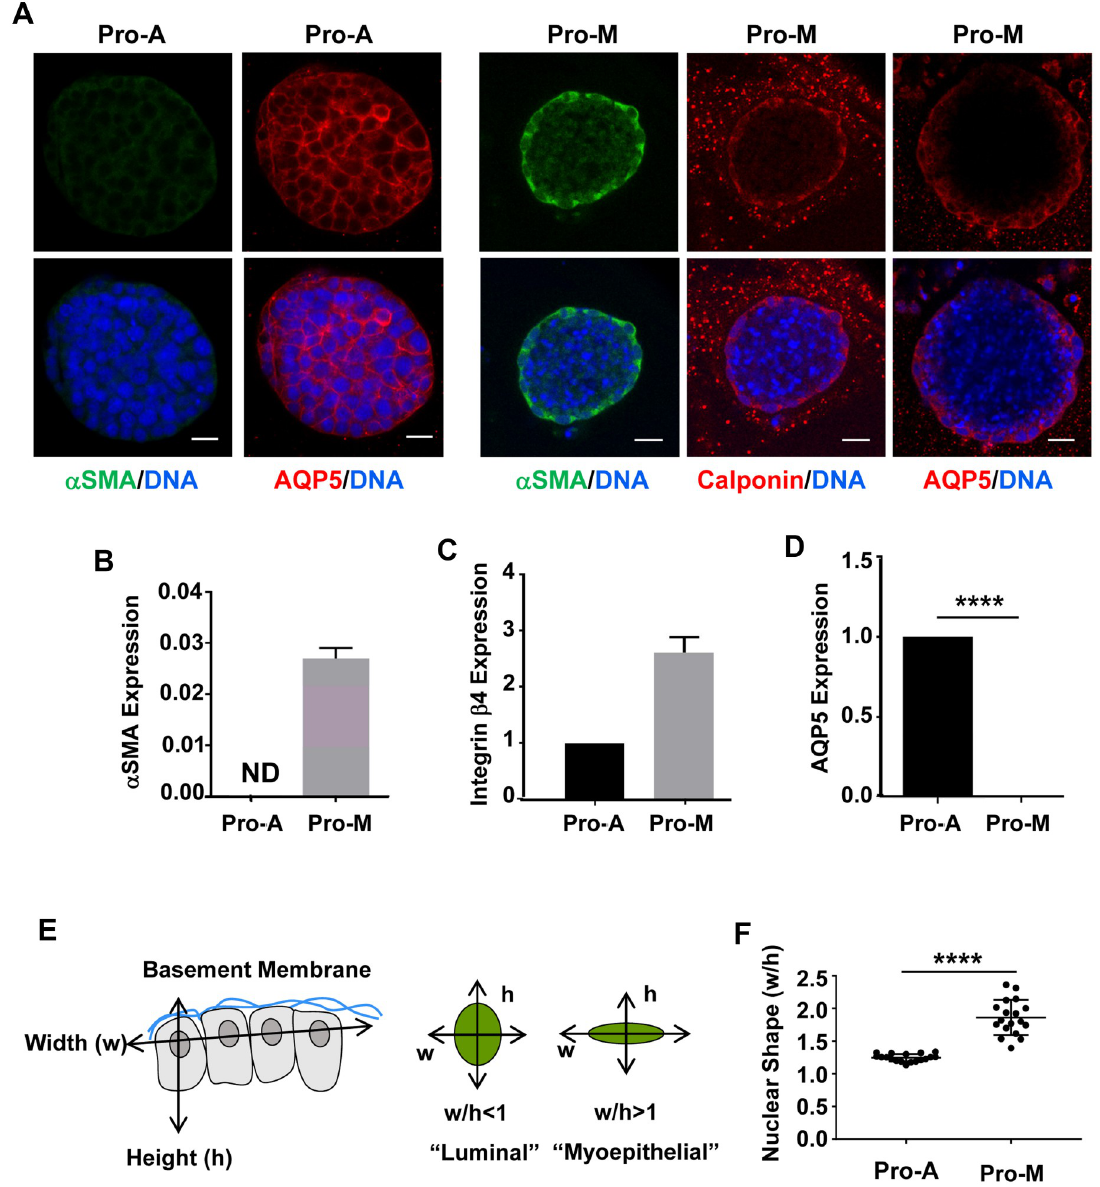
Fig 1. mSG-PAC1 cells can be induced to express myoepithelial markers and characteristics. (A) Representative confocal images of mSG-PAC1 spheroids cultured for six days in Matrigel in either a medium (Pro-A) that promoted pro-acinar phenotype or a medium (Pro-M) that promoted a myoepithelial phenotype and then immunostained for α SMA, calponin, AQP5 and DNA. Images are maximum projection images of five Z-slices acquired at 40X in 0.4 μ m increments. Scale bar, 25 μ m. Images are representative of three and two independent experiments for α -SMA and calponin, respectively. (B-D) Relative mRNA expression of α -SMA (B) , the integrin β 4 subunit (C) or AQP5 (D ) in mSG-PAC1 cells cultured for six days in Matrigel either in Pro-A or Pro-M medium. Expression is normalized to β -actin and then to expression in Pro-A condition. Data are from three independent experiments and plotted as the mean ± s.e.m. analyzed by Student’s T-test. ND = not detected. �� p < 0.01, ���� p < 0.0001. (E, F) mSG-PAC1 cells cultured in Pro-M medium display significantly flatter nuclei in cells at the basal periphery pf the spheroid. (E) Graphical representation of the method used to quantify nuclear shape using ImageJ. (F) Spheroids were cultured in either Pro-A or Pro-M medium for 6 days and immunostained for nuclei using DRAQ5. Width and height of nuclei relative to the basement membrane were quantitated in each cell at the basal periphery of spheroids using ImageJ Fiji. Data are from three independent experiments. Plotted is the mean nuclear width/height measured for each of eighteen spheres (n = 18) ± s.e.m. and analyzed by Student’s T-test. ���� p <